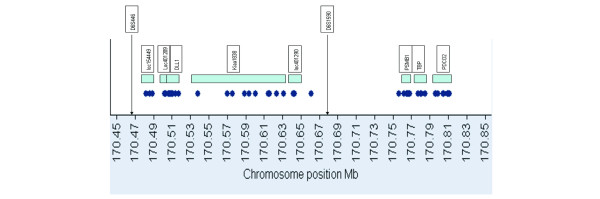
A schematic diagram of the IDDM8 region. The genes are shown in blue boxes, arrows denote position of the microsatellite markers associated in the Myerscough and colleagues study [9] and blue circles denote the single nucleotide polymorphisms.